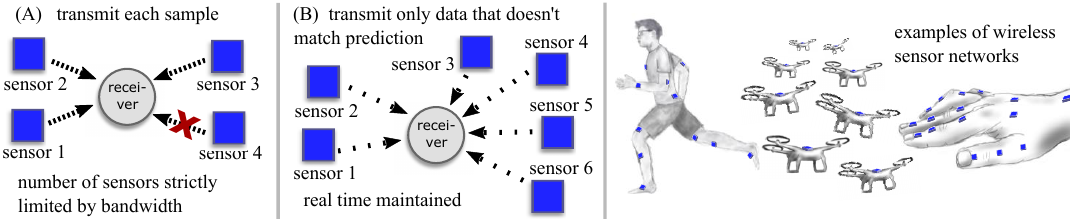
Figure 1. In wireless sensor networks, intelligent real-time communication protocols can reduce the communication load and enable the use of more